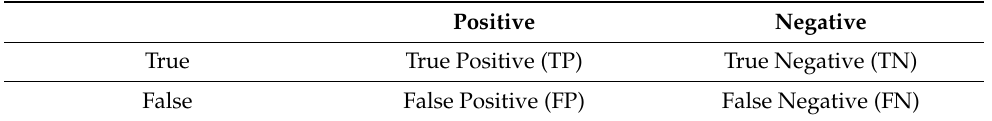
Table 2. Definition of evaluating